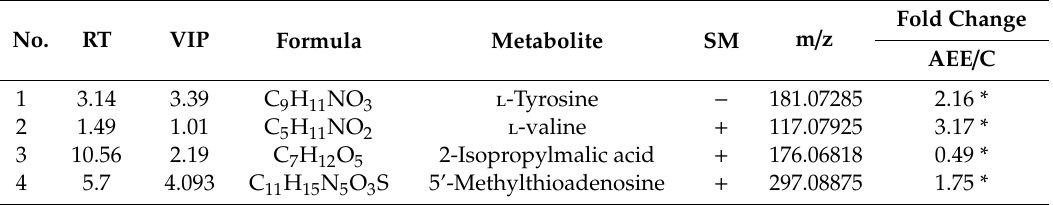
Table 2. The result of biomarkers identified in the cells and cell supernatants treated with AEE in the absence of H 2 O